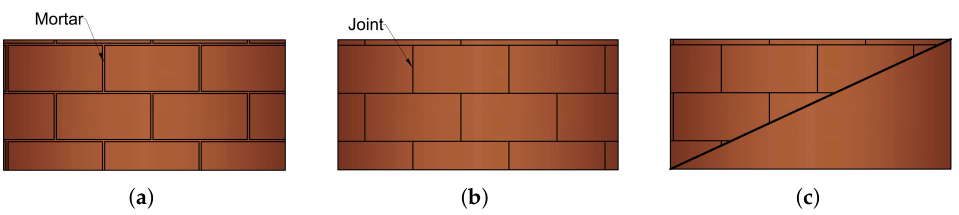
Figure 2. Different approaches to numerical modeling of masonry walls; ( a ) micro-model; ( b ) simpli- fied micro-model; ( c ) macro-model.